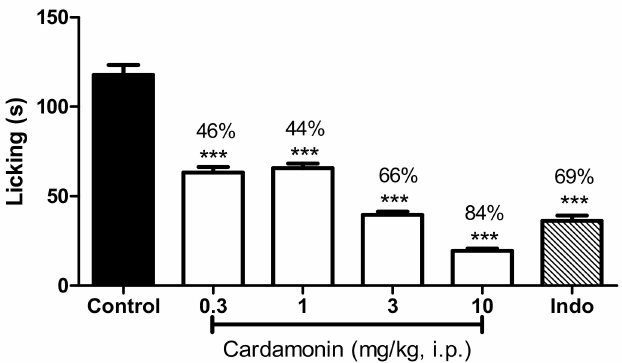
Figure 4. Effect of cardamonin (0.3, 1, 3, 10 mg/kg, i.p.) against glutamate-induced nociception. Each column represents the mean ± S.E.M. of 6 mice. Control group receives only the vehicle used to dilute the compound. Indomethacin (Indo, 10 mg/kg, i.p.) was used as positive control. The asterisks denote the significance levels compared with the control group (one-way ANOVA, followed by Dunnett’s post hoc test), *** p < 0.001. Values in parentheses are percentage of